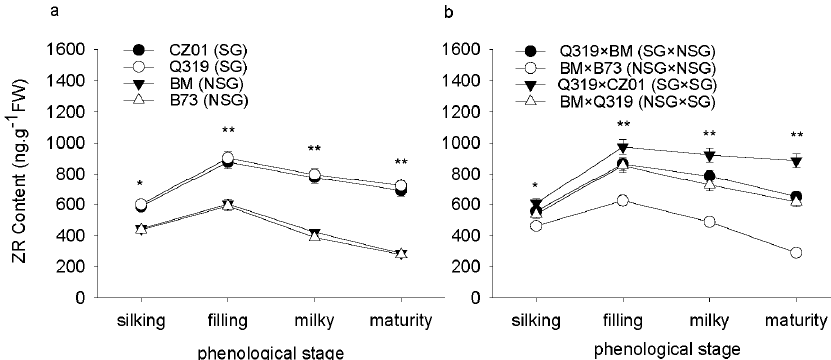
Figure 5. Zeatin riboside (ZR) content in ear leaves from different maize genetic backgrounds after silking. Values are means ± standard deviation ( n = 3). * indicates a significant difference between treatments at p < 0.05. ** indicates a significant difference between treatments at p < 0.01. ( a ) represents inbred lines, ( b ) represents hybrids. SG1 and SG2 are two types of maize for a higher stay-green ratio; CZ01, Q319, BM, B73 are the names of maize varieties.